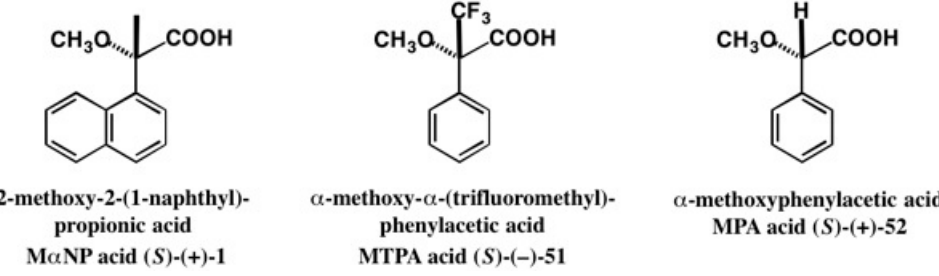
Figure 34. Chiral acids useful for the 1H-NMR diamagnetic anisotropy method.